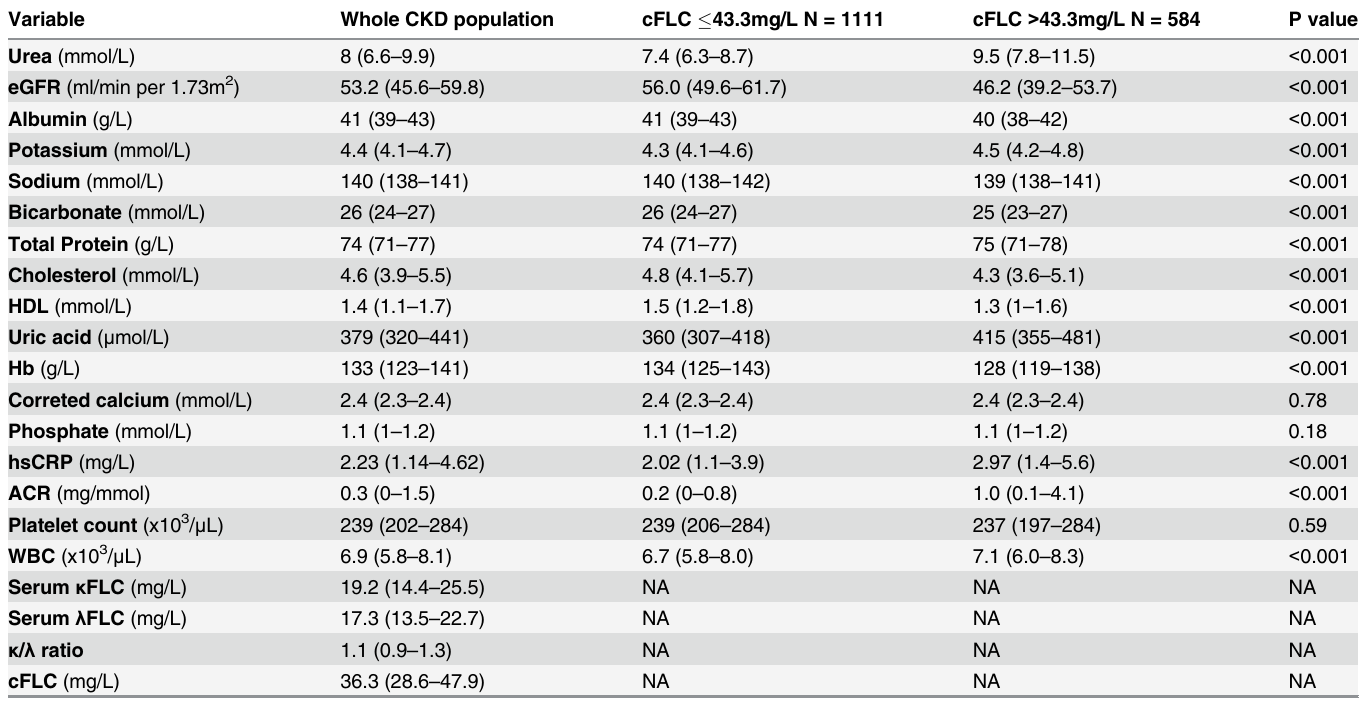
Table 2. Baseline patient characteristics in relation to serum cFLC